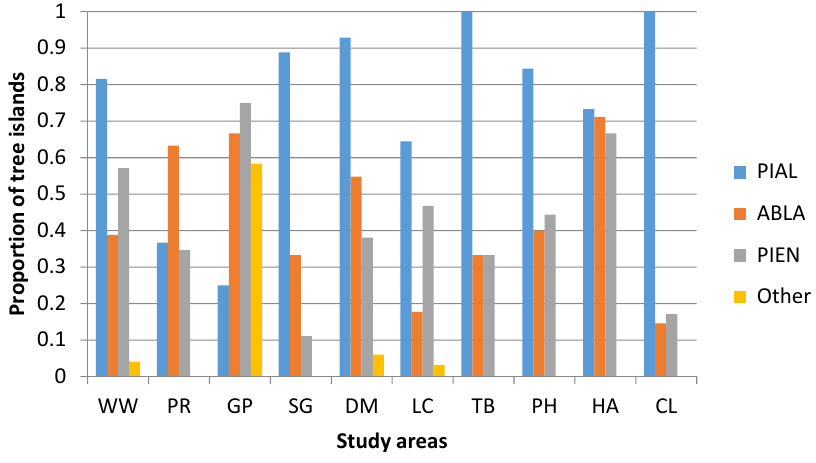
Figure 4. The proportion of tree islands within a study area with one or more individuals of each species. See Table 3 for conifer species listed under “Other”, and Figure 3 for conifer species abbreviations and study area abbreviations.